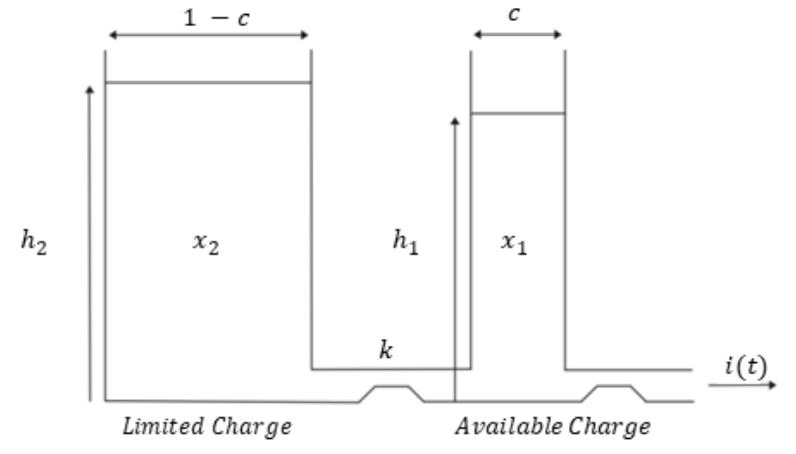
Figure 1. KiBaM Battery Model